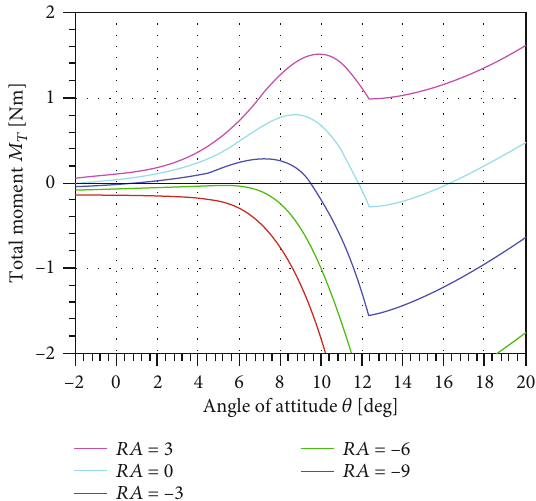
Figure 4: Aerodynamic characteristics of the